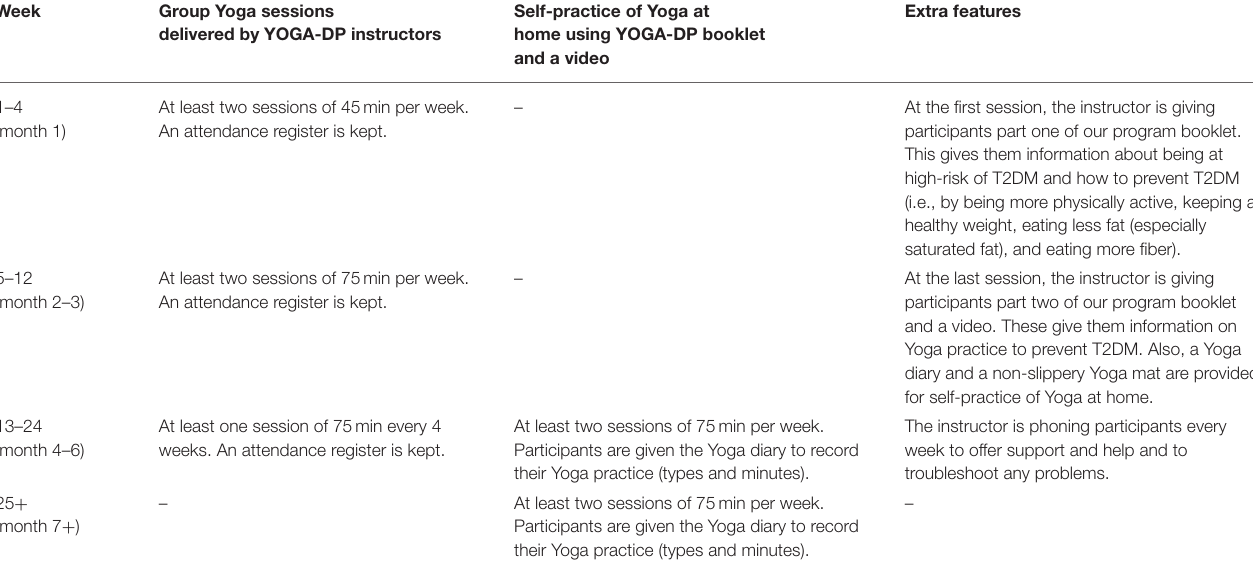
TABLE 3 | Structure of